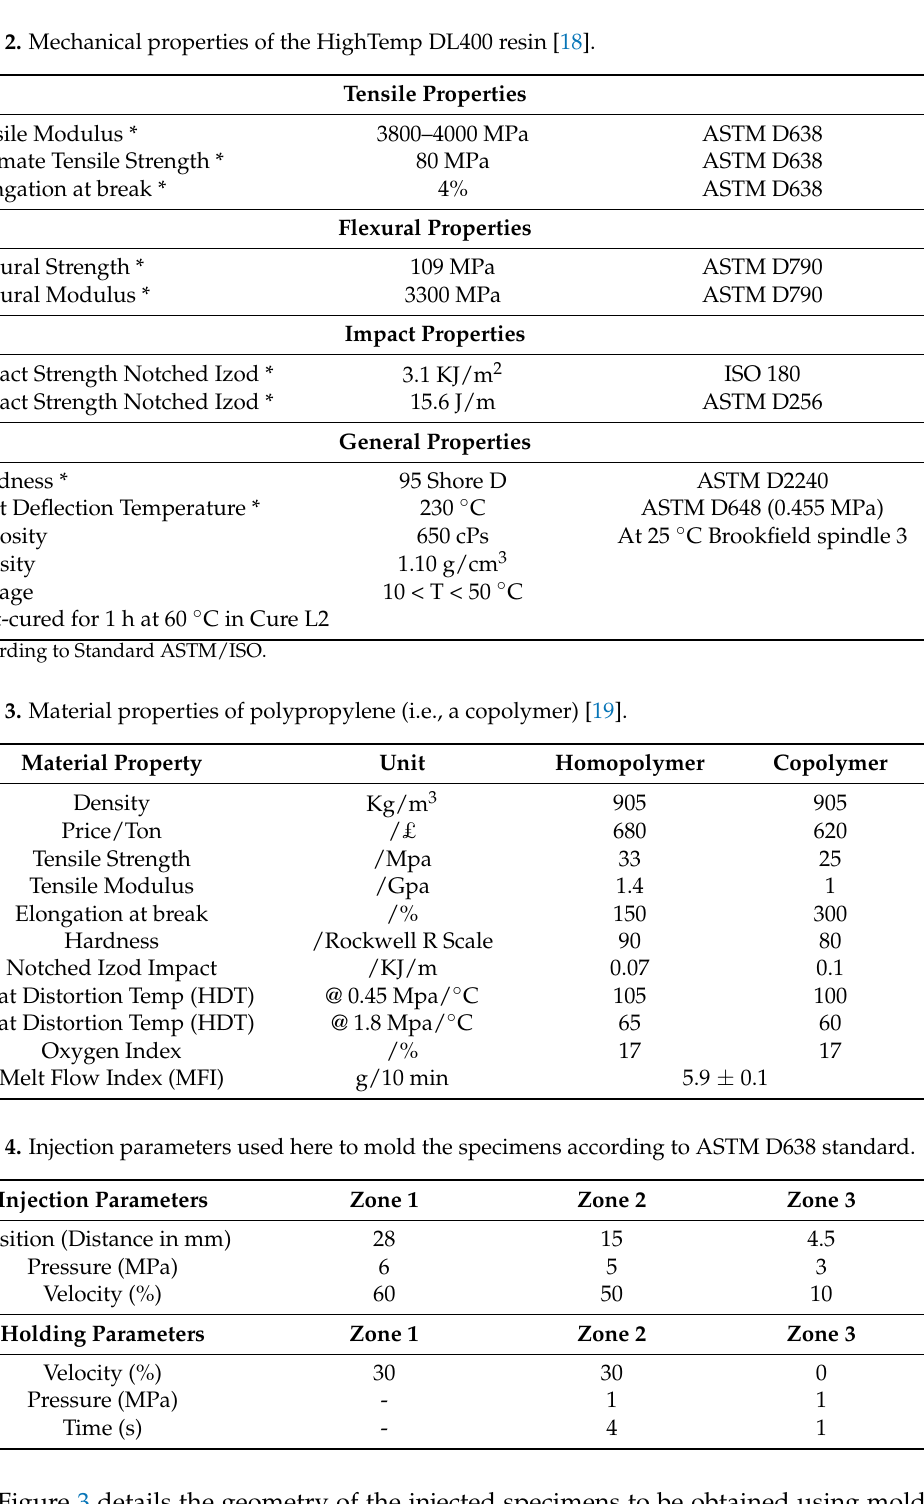
Figure 3 details the geometry of the injected specimens to be obtained using